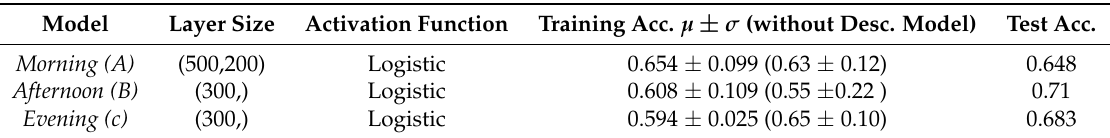
Table 2. We show in parentheses the accuracy of the probabilistic model without the description model. The afternoon model has the biggest improvement with respect to not using description model because it has more short duration activities. Precision and Recall measures for the combined and the probabilistic model per activity are shown in Figure 1. Table 2. Selected parameters and mean training accuracy using a leave-one-day out cross validation model selection.